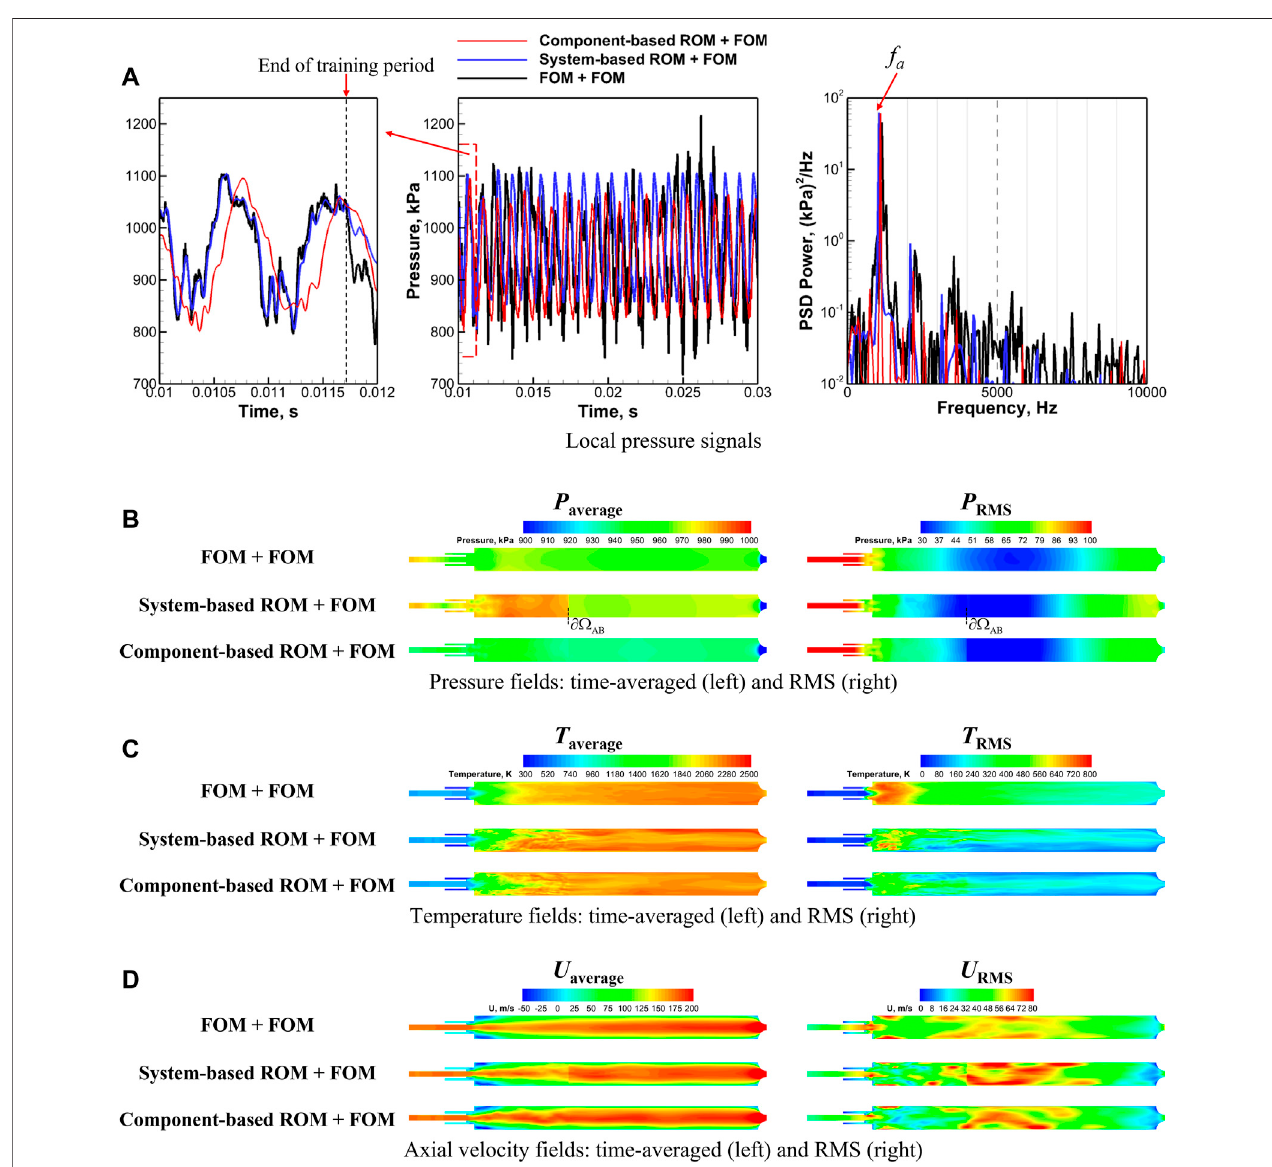
FIGURE 6 | Comparisons of (A) pressure signals measured at x = 0 in (B) pressure, (C) temperature, and (D) axial velocity time-averaged (left) and root-mean- square (right) fi elds with different models (component-based ROM vs. system-based ROM vs. FOM) used for the upstream injector element ( Ω A ) for the single-injector